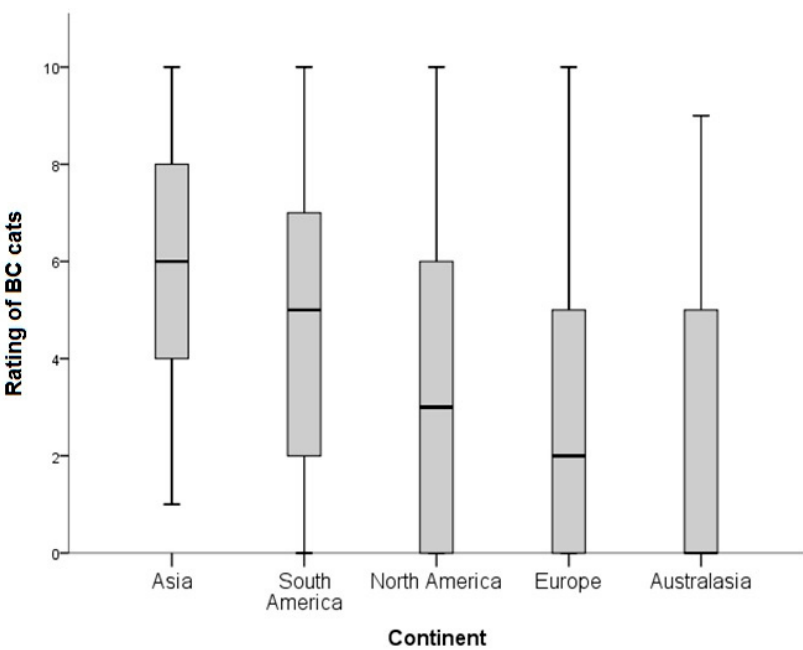
Figure 4. Ratings of liking (0 = I don’t like this cat at all; 10 = This is my favorite kind of cat) for cats identified as having mild to extreme brachycephaly (BC; n = 7/15 cat images as per Table 1). Ratings were provided by n = 1239 respondents. Comparisons are relative to skull morphology of the eldest cat currently owned, as based on reported breed and associated pedigree breed standards.